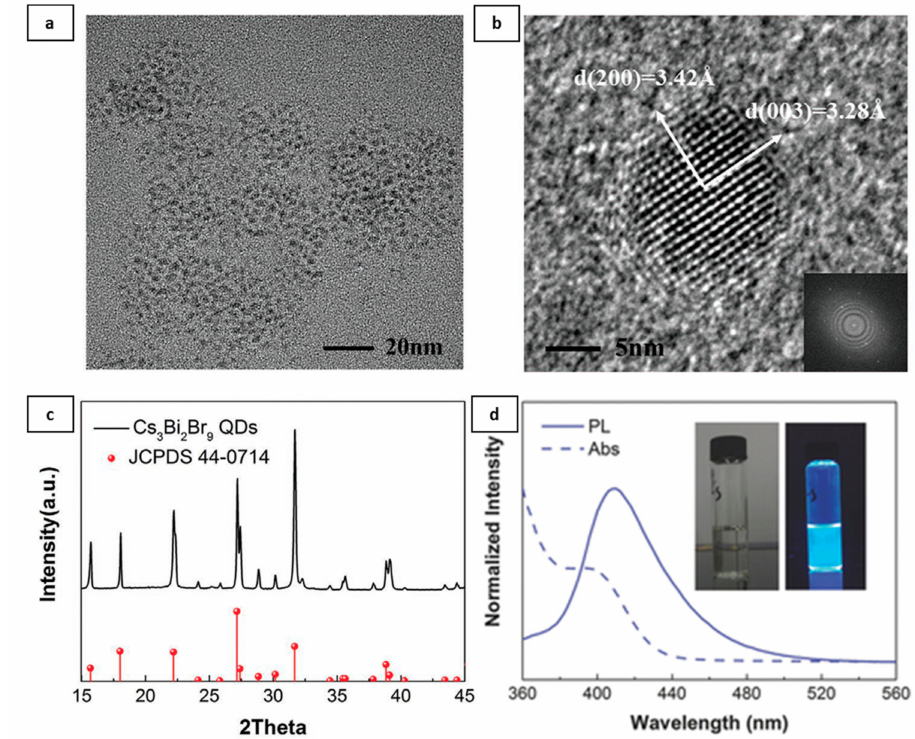
Figure 8. Characterizations of Cs 3 Bi 2 Br 9 QDs. ( a ) TEM image. ( b ) High-resolution TEM (HRTEM) image of a typical QD. ( c ) XRD patterns of QD powder. ( d ) Absorption and PL spectra. Insets: Typical optical images of the QD solution in ambient under a 325 nm UV lamp